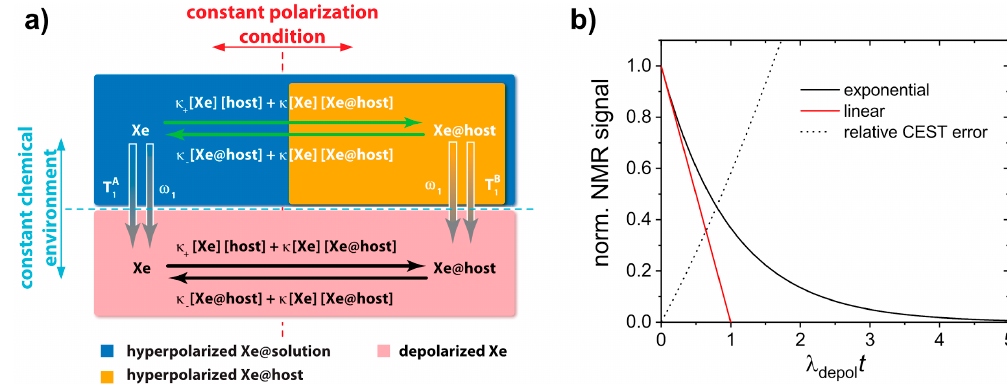
Figure 14. Aspects of qHyperCEST analysis. ( a ) Exchange-connected spin pools and depolarization pathways evaluated in qHyperCEST. Adapted from Supp. Inf. of [76]. ( b ) Exponentially driven depolarization given by the depolarization parameter λ depol and applied saturation time. For CEST effects <25–30%, the behavior can be approximated by a linear slope and the relative CEST error remains below 20%.